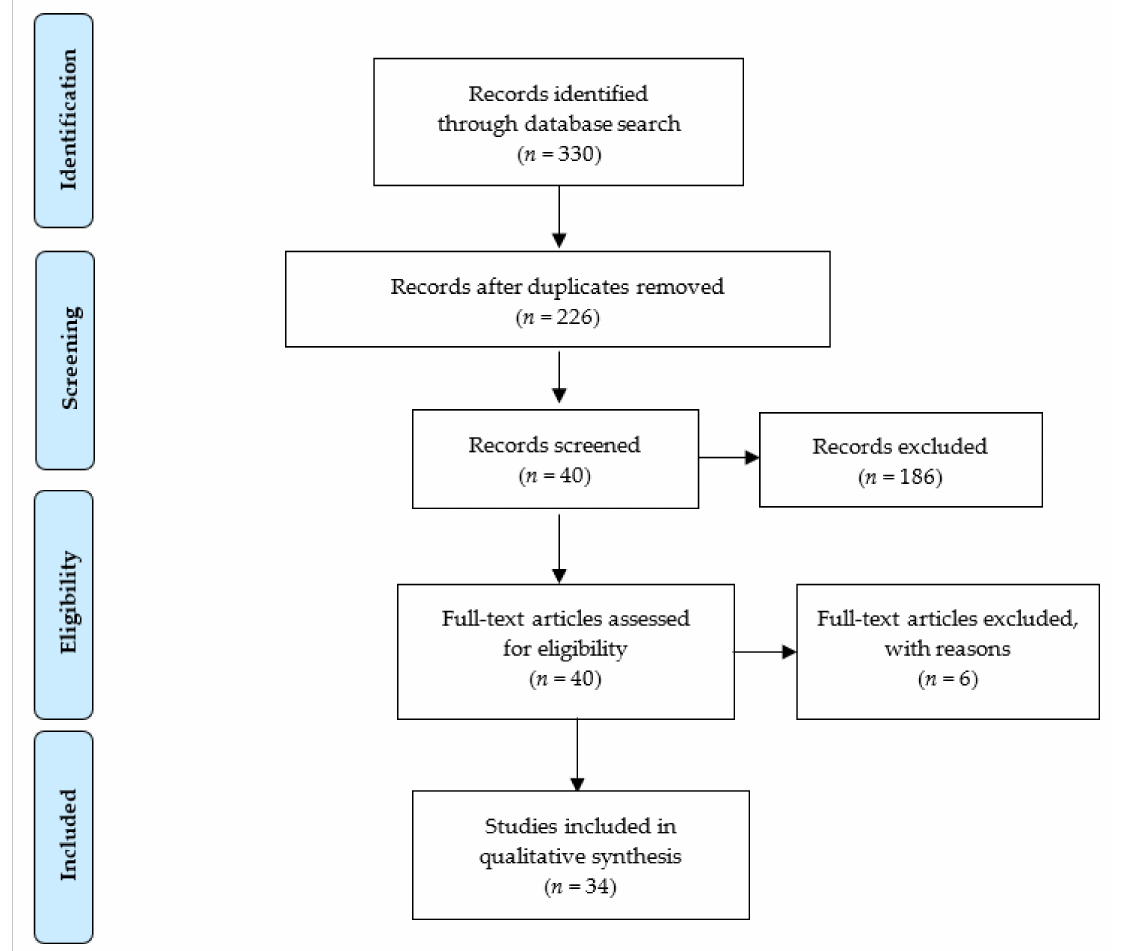
Figure 1. PRISMA flow diagram of search history and selection of